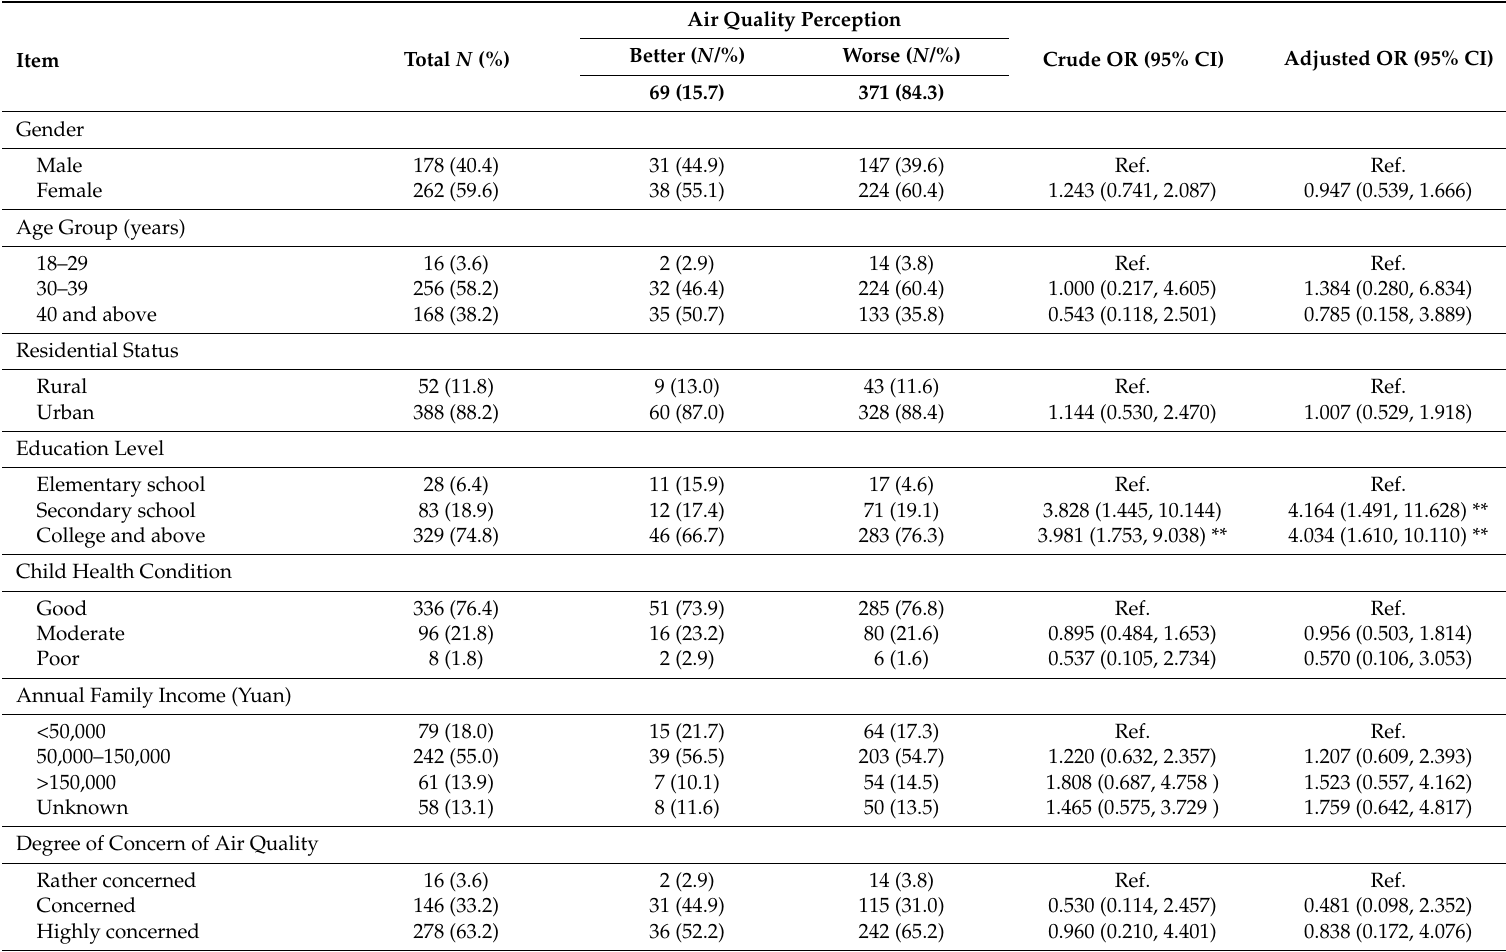
Table 2. Logistic regression analysis (OR and 95% CI) for air quality perception: at the individual level in the community